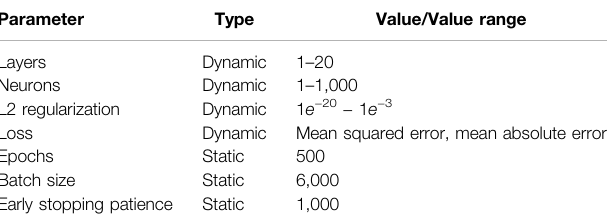
TABLE 3 | Hyperparameter optimization - static and dynamic parameters.